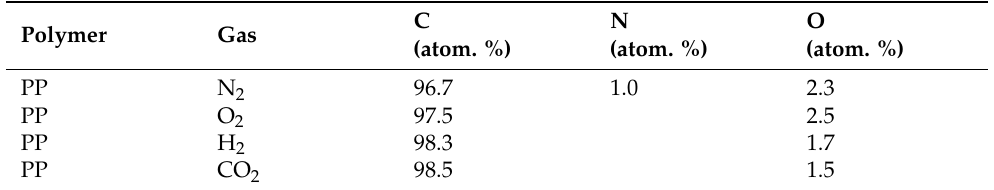
Table 4. XPS surface composition of the deposits synthesized from PP polymer using various gaseous